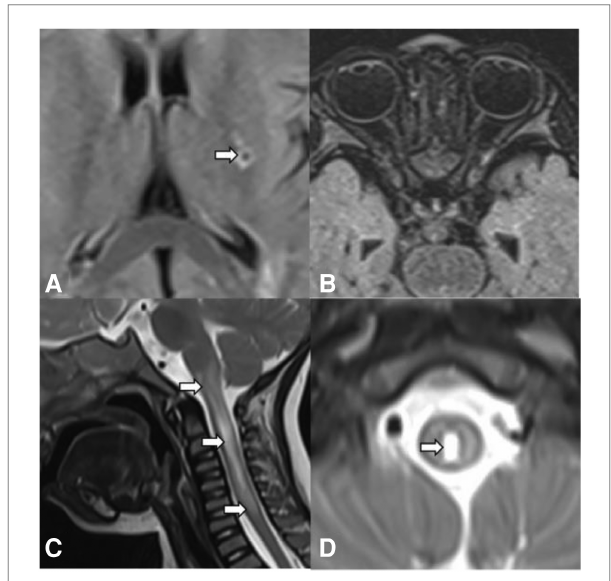
FIGURE 1 Brain MRI, spinal cord MRI, and optic MRI of the patient. Axial T2- weighted fl uid-attenuated inversion recovery (FLAIR) MRI shows small encephalomalacia foci with gliosis in the left basal ganglia ( A , arrows) and normal optic nerves ( B ). Sagittal ( C ) and axial ( D ) T2-weighted MRI of the spinal cord demonstrates longitudinally extensive transverse myelitis (LETM) lesion involving medulla to C6 leve